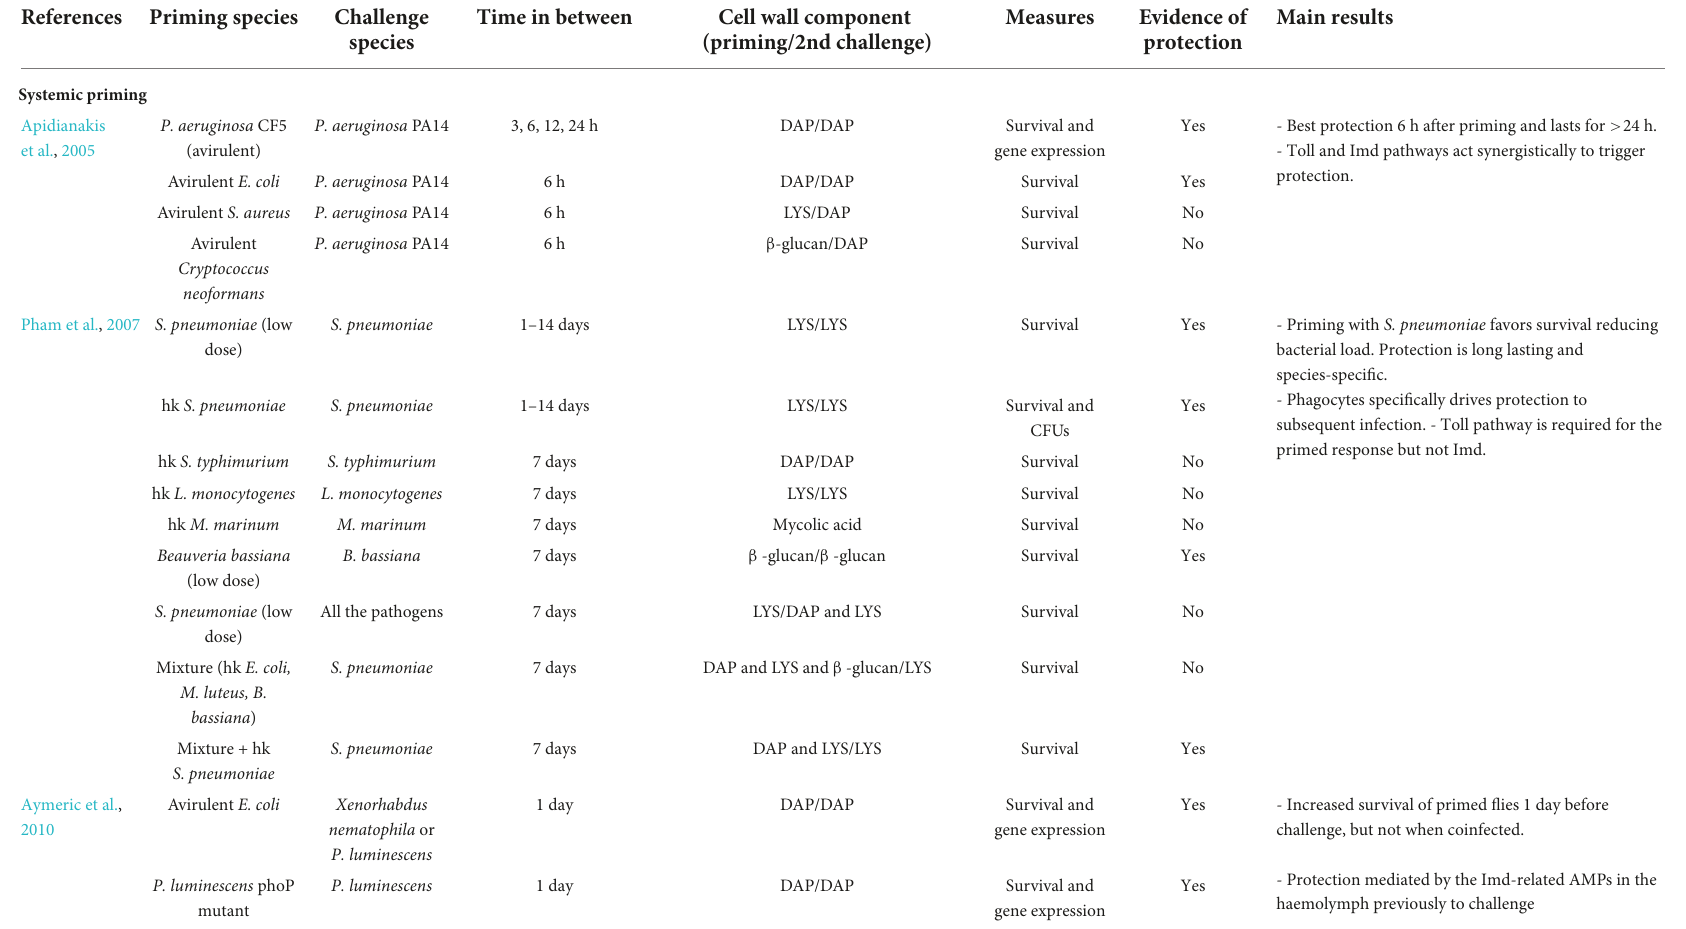
TABLE 1 Studies assessing innate immune memory in Drosophila melanogaster